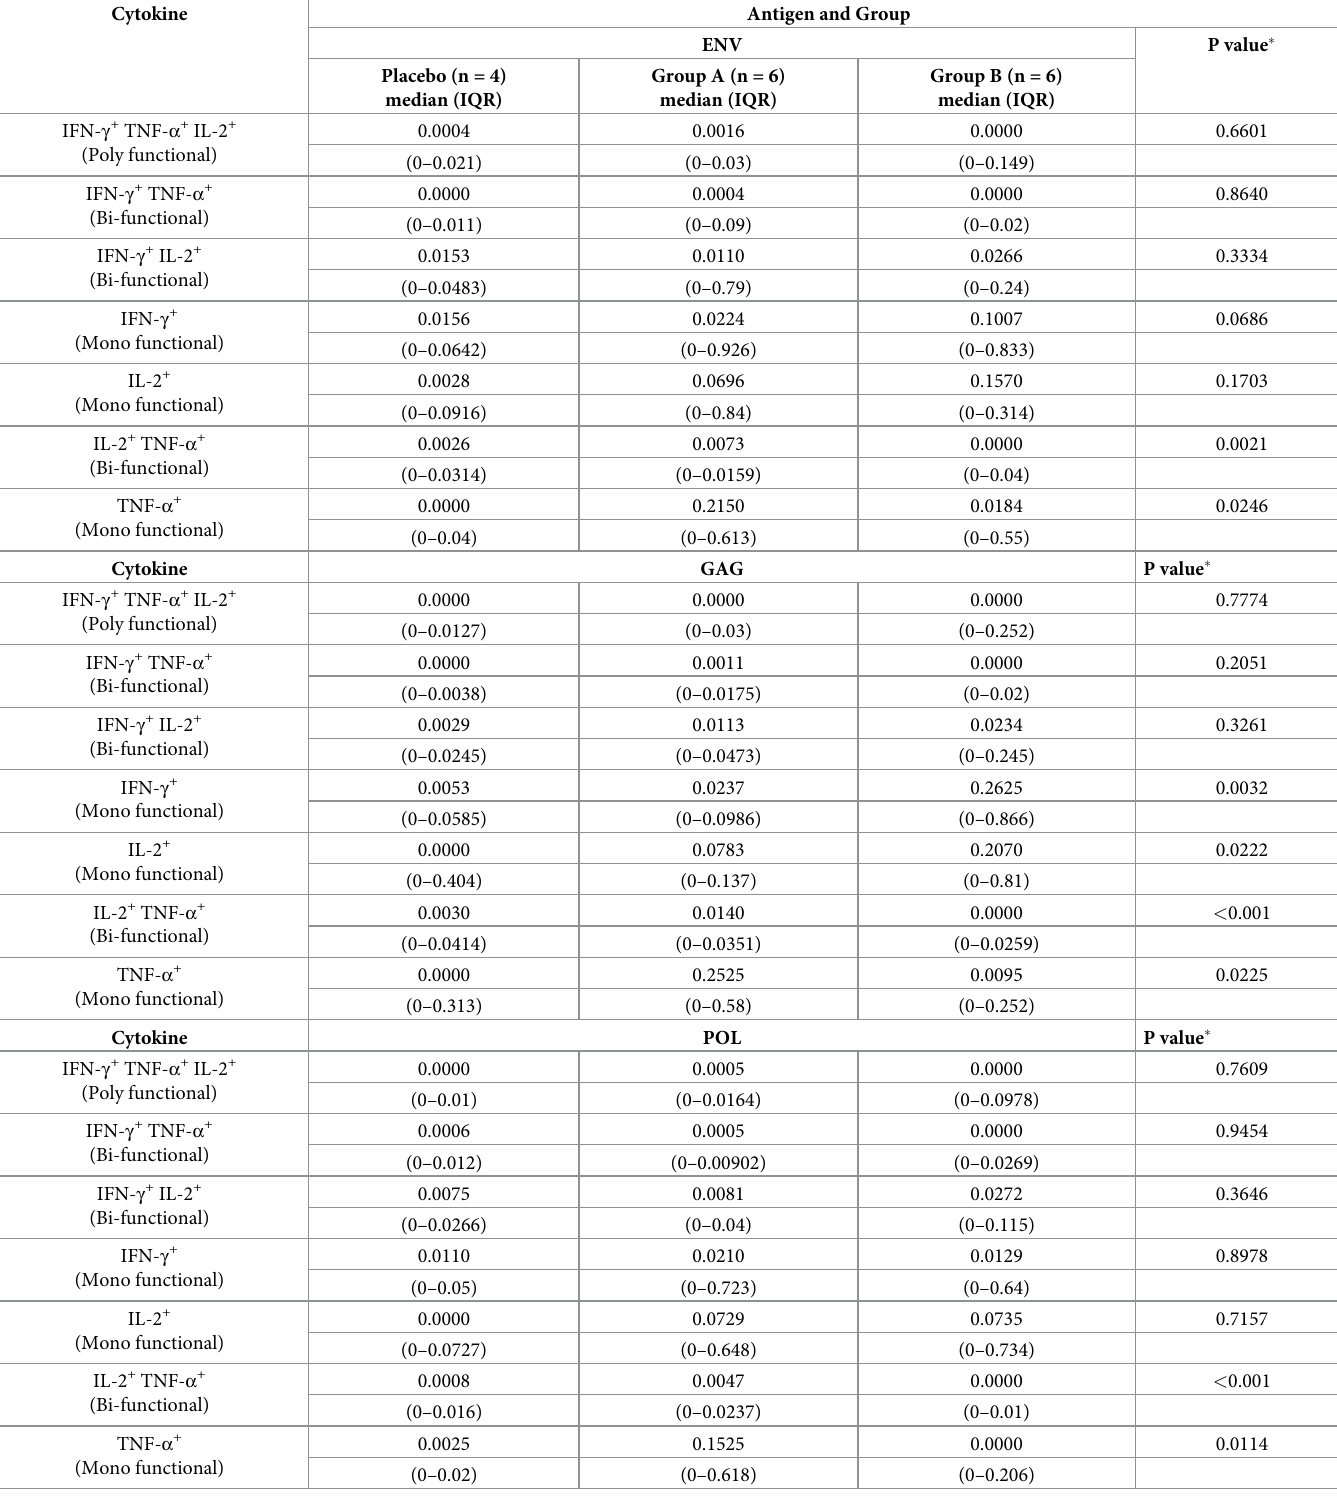
Table 4. Vaccine-induced peptide specific CD4 + T cell cytokine responses across the period of